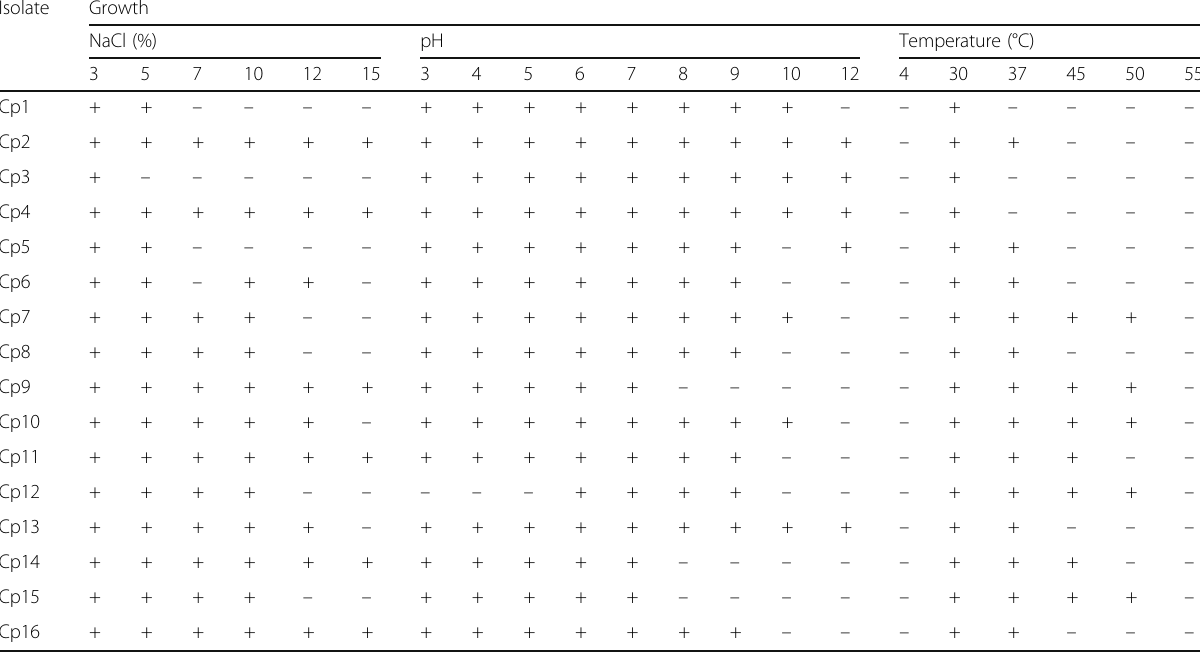
Table 2 The physiological properties of the bacterial isolates. Luria-Bertani broth was used as growth medium Isolate